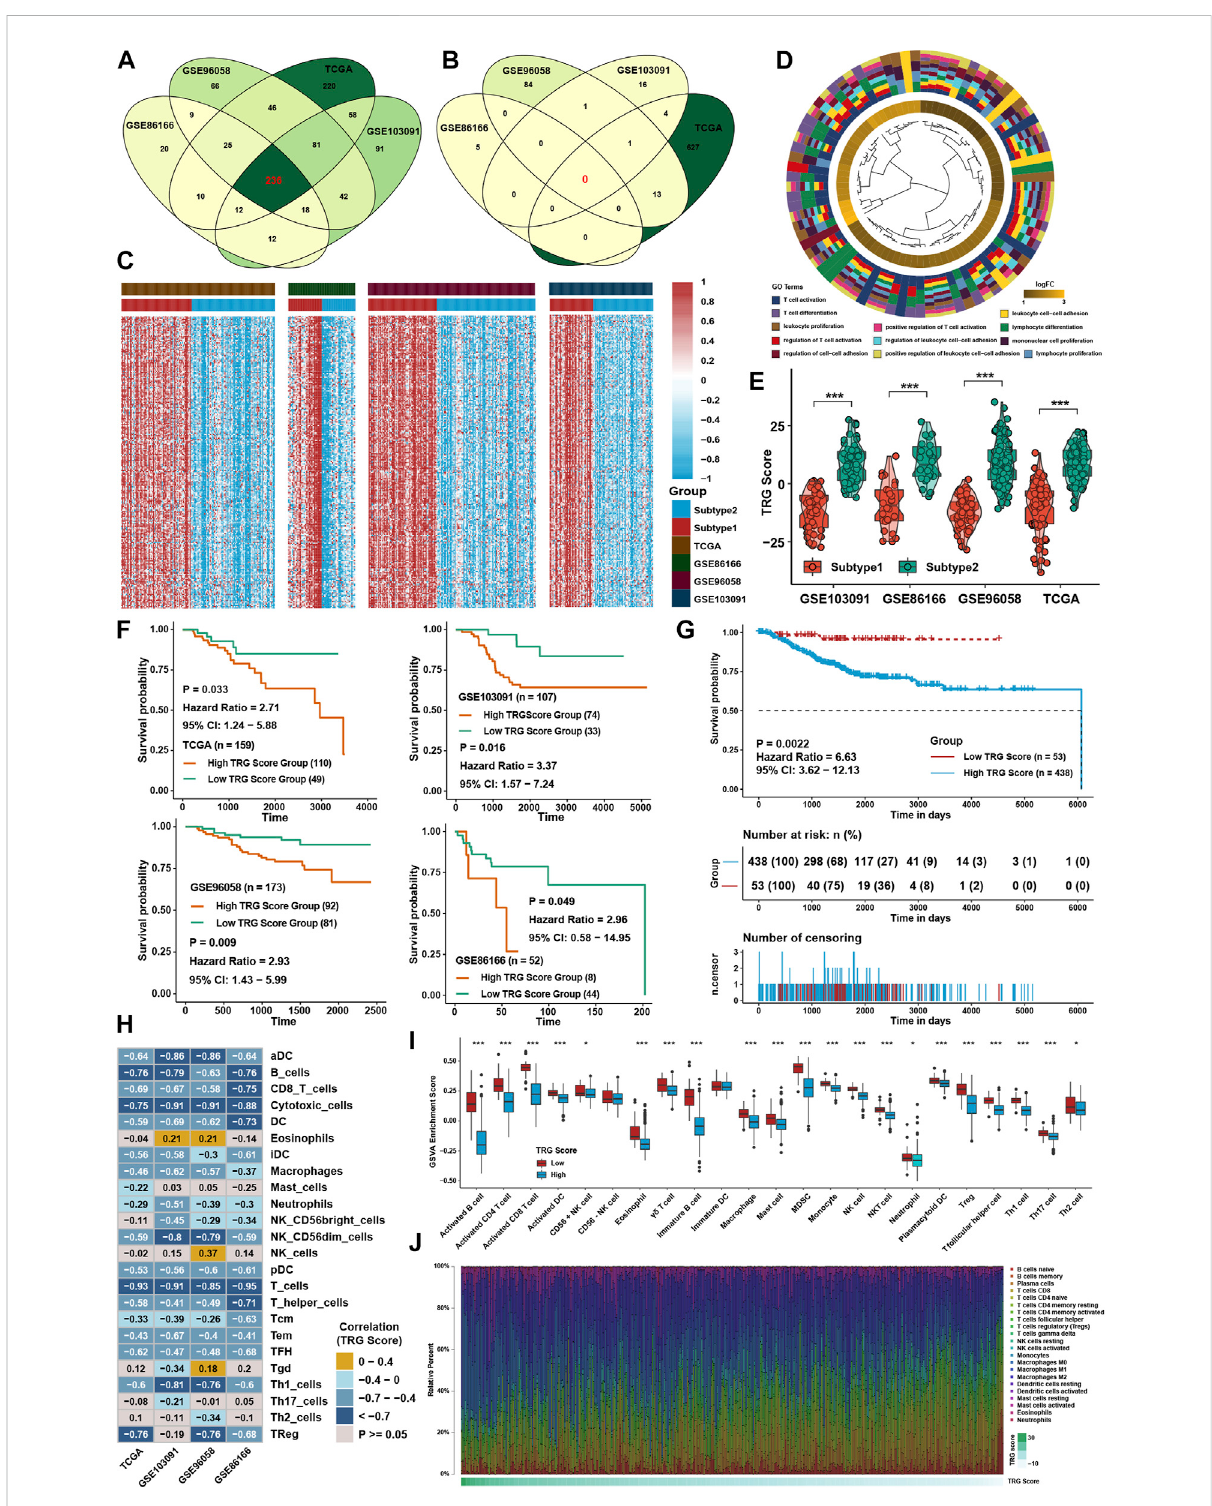
FIGURE 5 GenerationofTRGscoreandfunctionalveri fi cation. (A) IntersectionofupregulatedDEGsbetweentwoTMEsubtypesinfourTNBCcohorts. (B) Intersection of downregulated DEGs between two TME subtypes in four TNBC cohorts. (C) Heatmap of DEGs between two TME subtypes in four TNBC cohorts. (D) GO analysis of DEGs intersected between the two TME subtypes. (E) Differences in TRG score between TME subtypes in four TNBCcohorts. (F) SurvivalanalysisfortheTRGscoreinfourTNBCcohorts. (G) SurvivalanalysisfortheTRGscoreinthewholeTNBCcohort. (H) CorrelationanalysisbetweentheTRGscoreandimmunecellin fi ltrationlevelscalculatedbyimmunecellsignature1. (I) Immunecellin fi